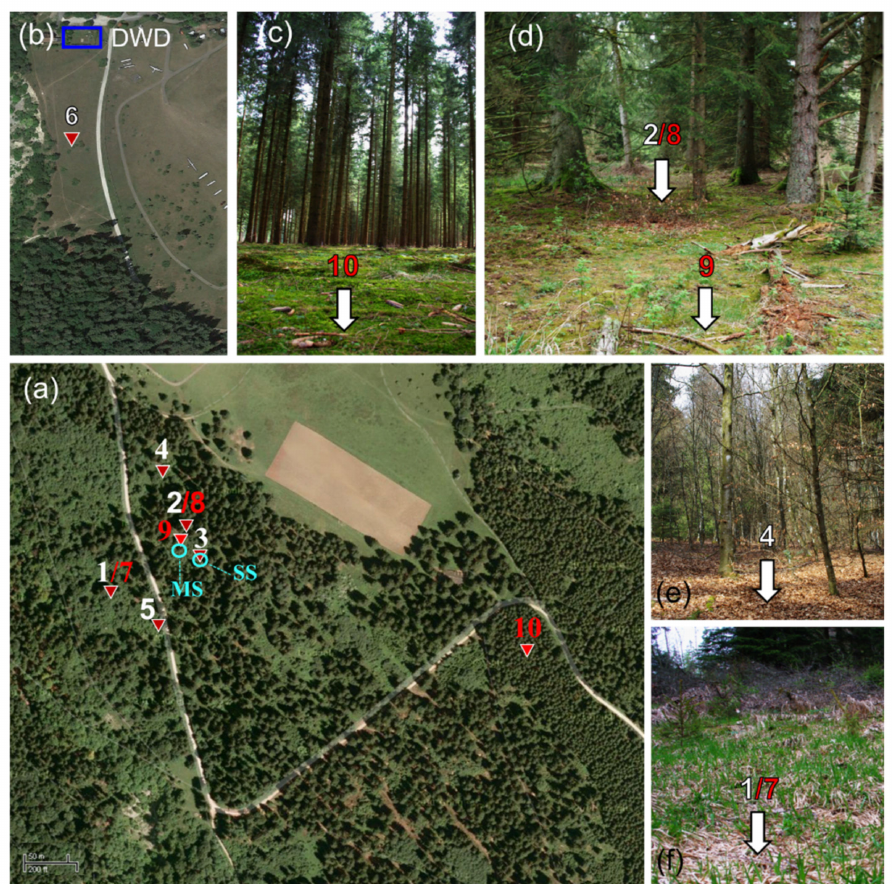
Figure 1. Overview of the locations of the individual measuring spots of the DWD station (blue), micrometeorological stations (MS, SS), the Micro-Loggers of System-1 (white, ML-1 to ML-6) and System-2 (red, ML-7 to ML-10). The graphs give an aerial view (source: Google maps) from the forest ( a ), the adjoining open land to the north ( b ) as well as images of four diverse forest measurement spots ( c – f